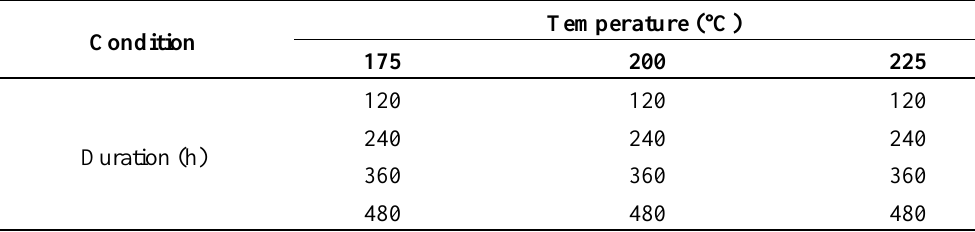
Table 3. High temperature storage conditions for intermetallic growth.